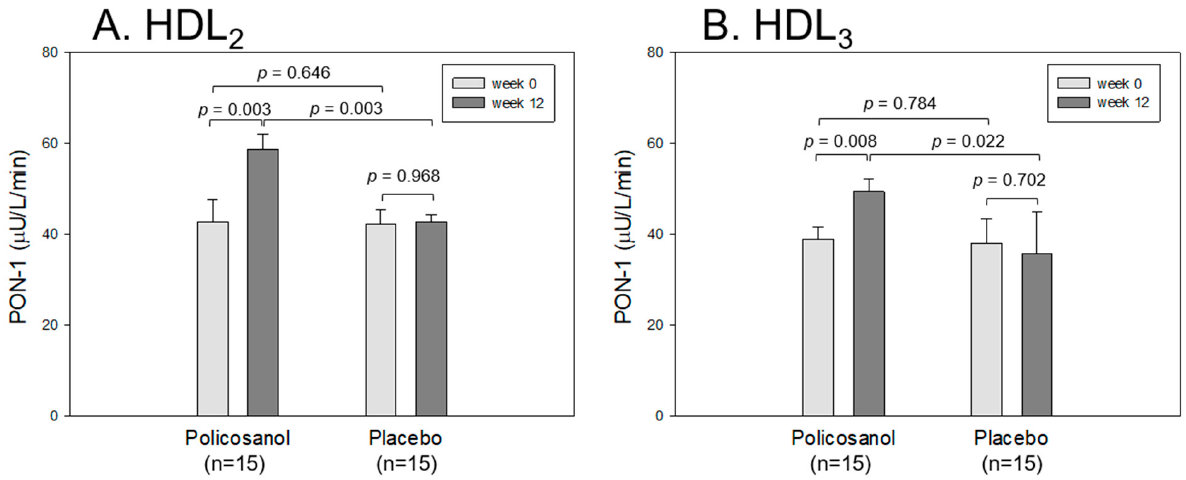
Figure 6. Comparison of the paraoxonase (PON-1) activity in HDL 2 ( A ) and HDL 3 ( B ) from the policosanol and placebo groups between weeks 0 and 12. The PON-1 activity is expressed as the initial velocity of p -nitrophenol production per min ( μ U/L/min) at 37 °C during 60 min of incubation. The data are expressed as the mean ± SD from three independent experiments with duplicate samples. The PON-1 activity in each group between weeks 0 and 12 was compared using a paired t -test.